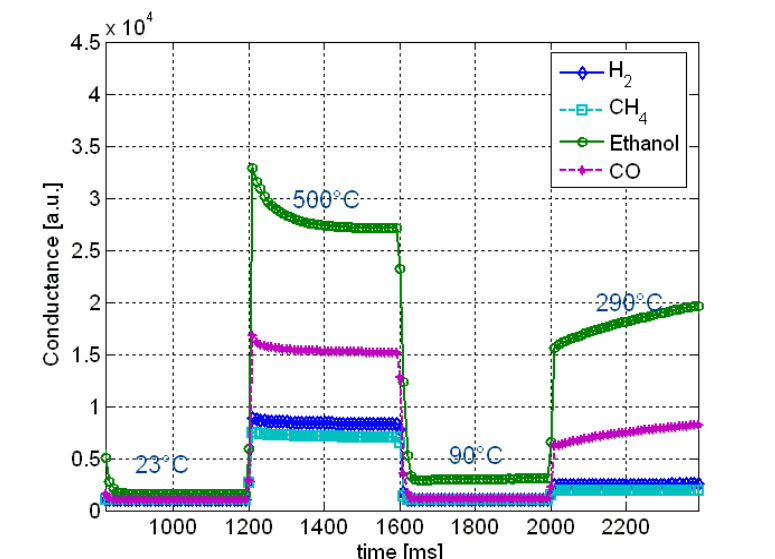
Figure 16. A snapshot of response curves of a gas sensor is shown for H (1,000 ppm), ethanol (2.4 ppm), and CO (400 ppm) at 70% relative